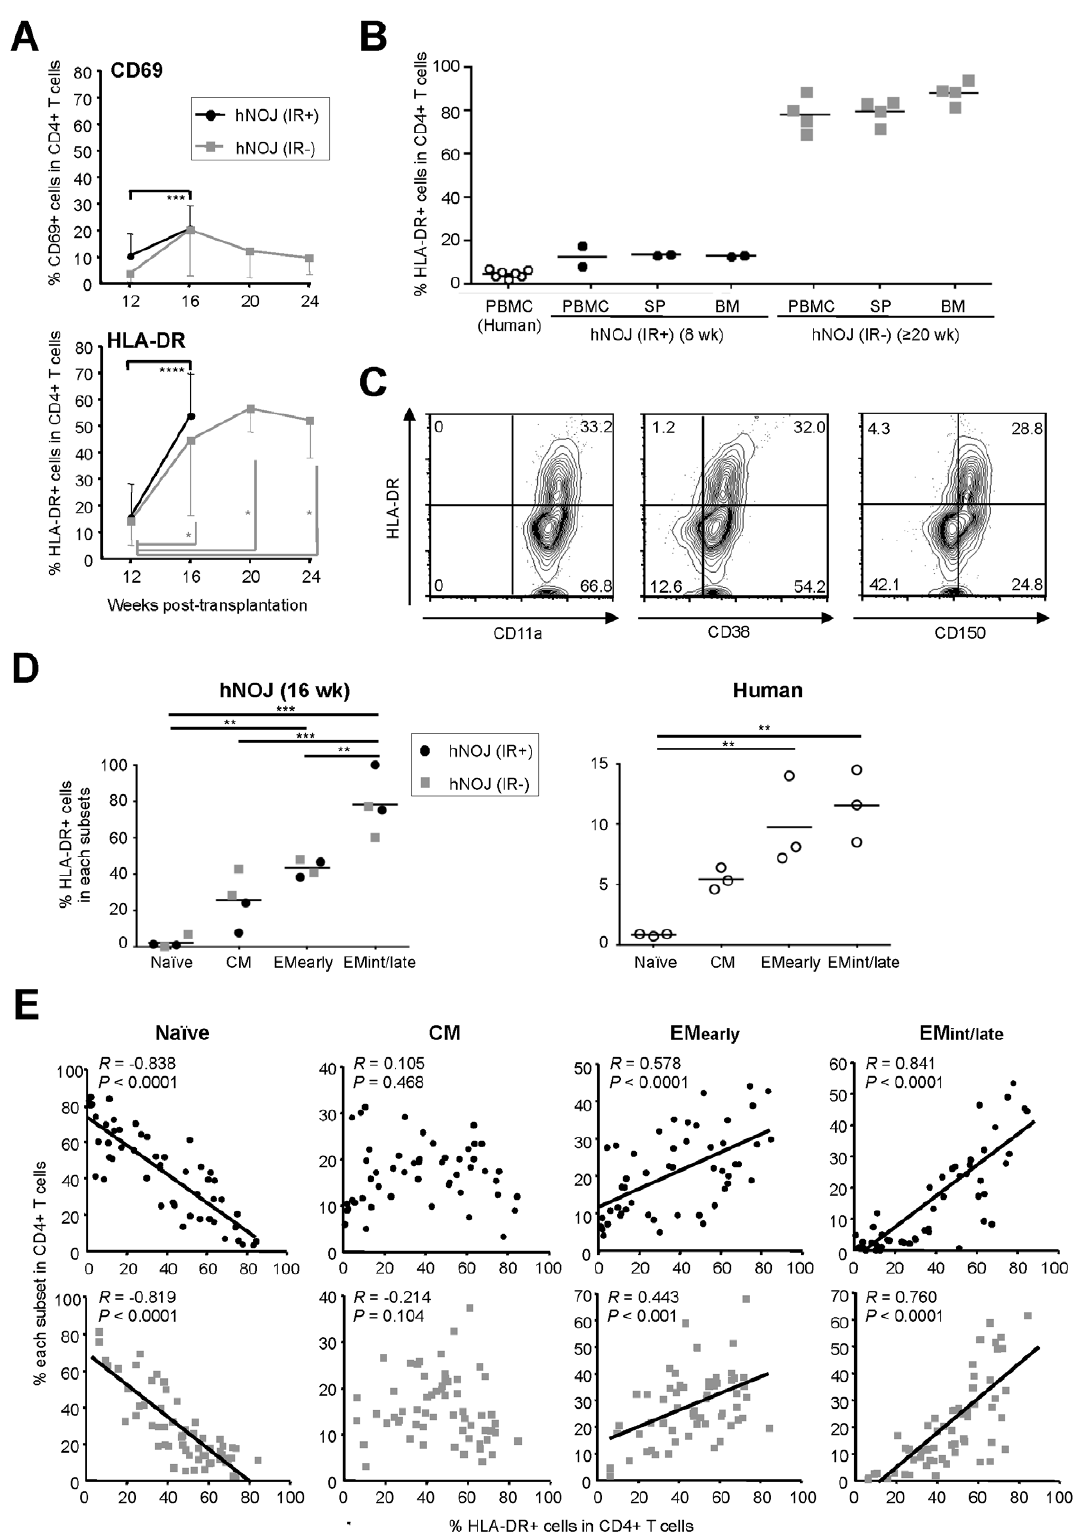
Figure 4. Activation status of CD4 + T Cells in hNOJ mice. (A) Changes in the percentage of CD69 + (upper) and HLA-DR + (lower) cells within the peripheral blood CD4 + T cells isolated from hNOJ (IR + ) and hNOJ (IR 2 ) mice ( n =18 and n =6, respectively). Data are expressed as the mean 6 SD. Significant differences ( * P , 0.05, **** P , 0.0001) were determined using the Wilcoxon signed rank test or a paired t test. (B) Percentage of HLA-DR + cells within the CD4 + T cell populations isolated from PBMCs, spleens (SP), and BM from hNOJ (IR + ) mice at 8 wk post-transplantation ( n =2) and hNOJ (IR 2 ) mice at $ 20 wk post-transplantation ( n =4), and from human PBMCs ( n =7). Data are plotted individually. The black line represents the mean.